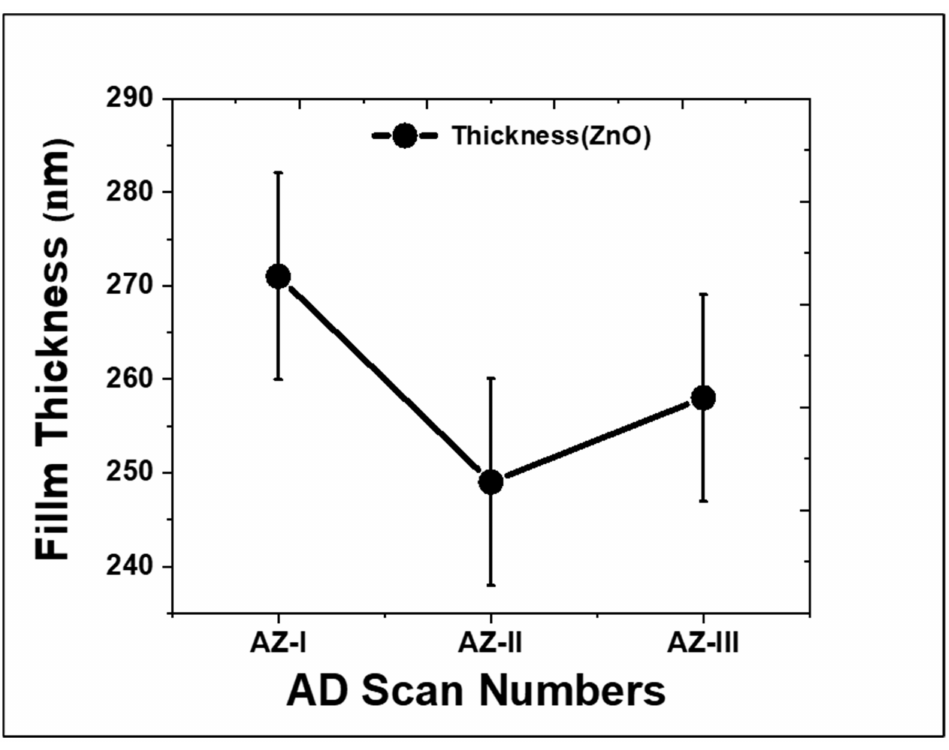
Figure 6. The thickness of ZnO films obtained with different deposition cycles.